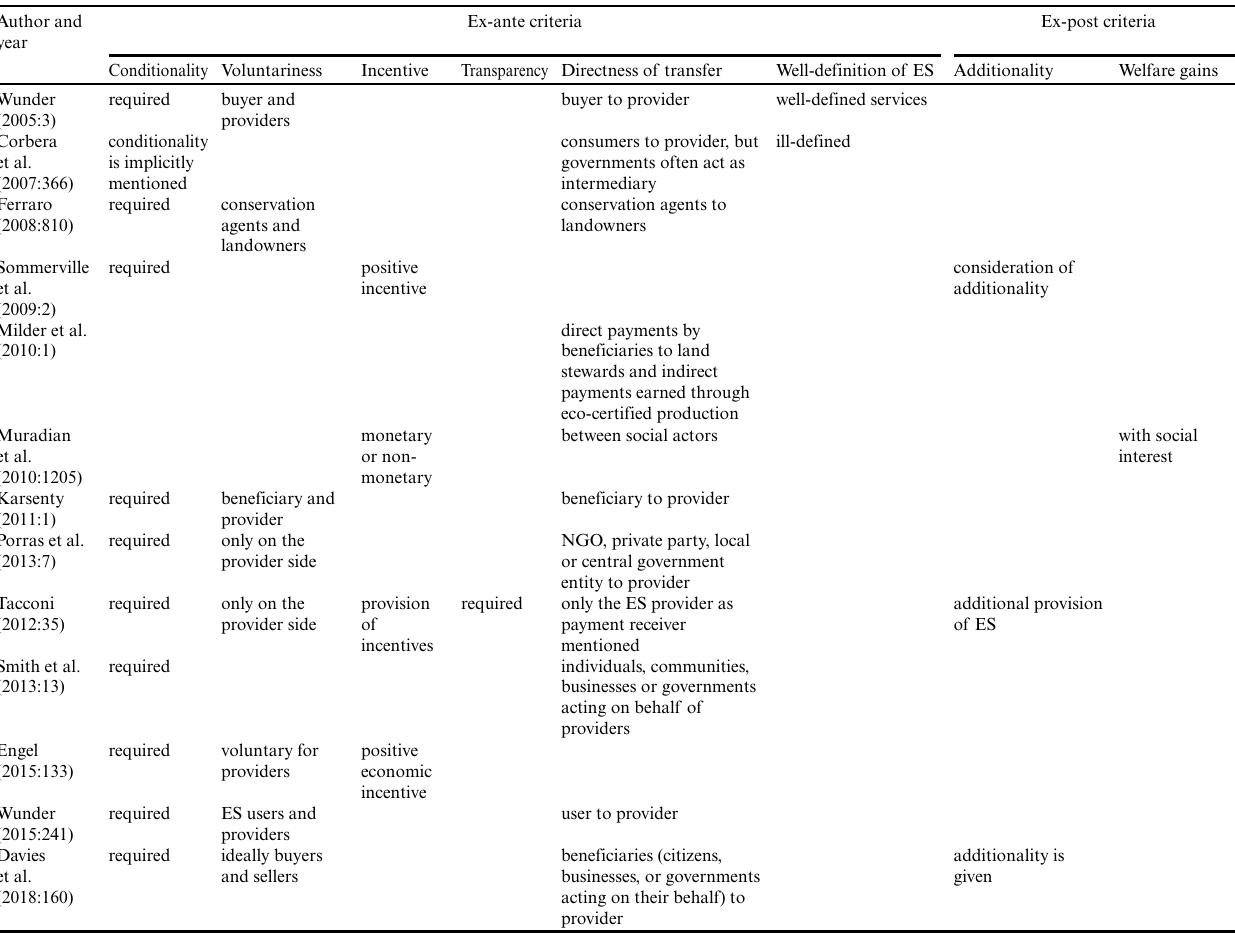
Table 1 . Overview of criteria assigned to different payments for ecosystem services (PES)